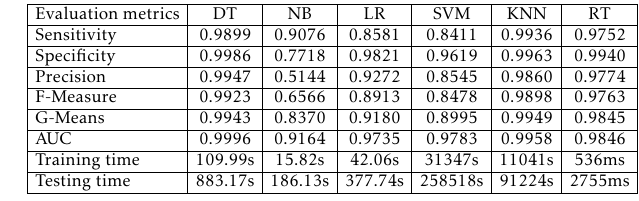
Table 4. Results of using AdaBoost when classifying DoS on UNSW-NB15 dataset